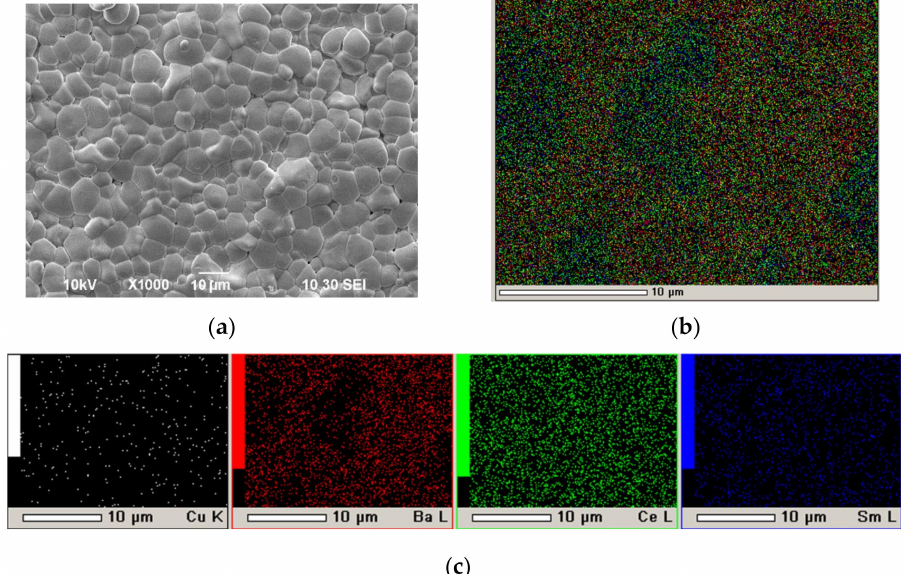
Figure 6. The surface of the BCSCuO electrolyte layer after the final sintering at 1500 ◦ C for 3 h on the dense SDC substrate with the platinum sublayer (Sample SDC-Pt-BCSCuO): ( a ) SEM image; ( b ) Integrated map of the element distribution; ( c ) Maps of the individual